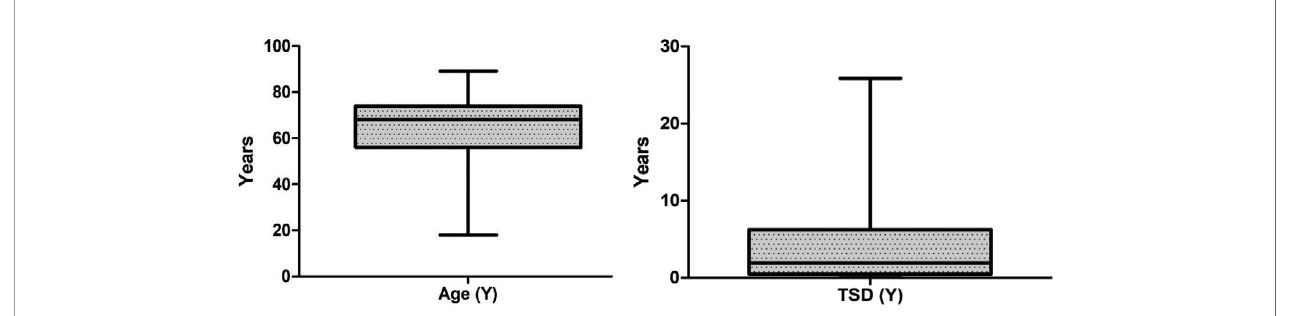
FIGURE 1 | Box plot showing median values and interquartile range (IQR) for age and time since diagnosis